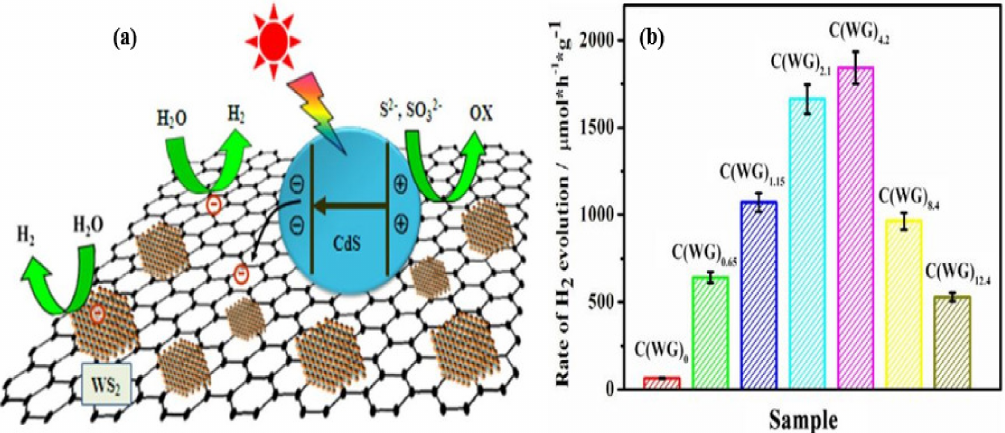
Figure 7. ( a ) Schematic illustration of the tentative mechanism proposed for the high H 2 -production activity of the ternary CWG composite and ( b ) Comparison of the photocatalytic activity of the C(WG) 0 , C(WG) 0.65 , C(WG) 1.15 , C(WG) 2.1 , C(WG) 4.2 , and C(WG) 12.4 samples for the photocatalytic H 2 production. (Reprinted with permission from reference [122]. Copyright 2016, John Wiley and Sons).